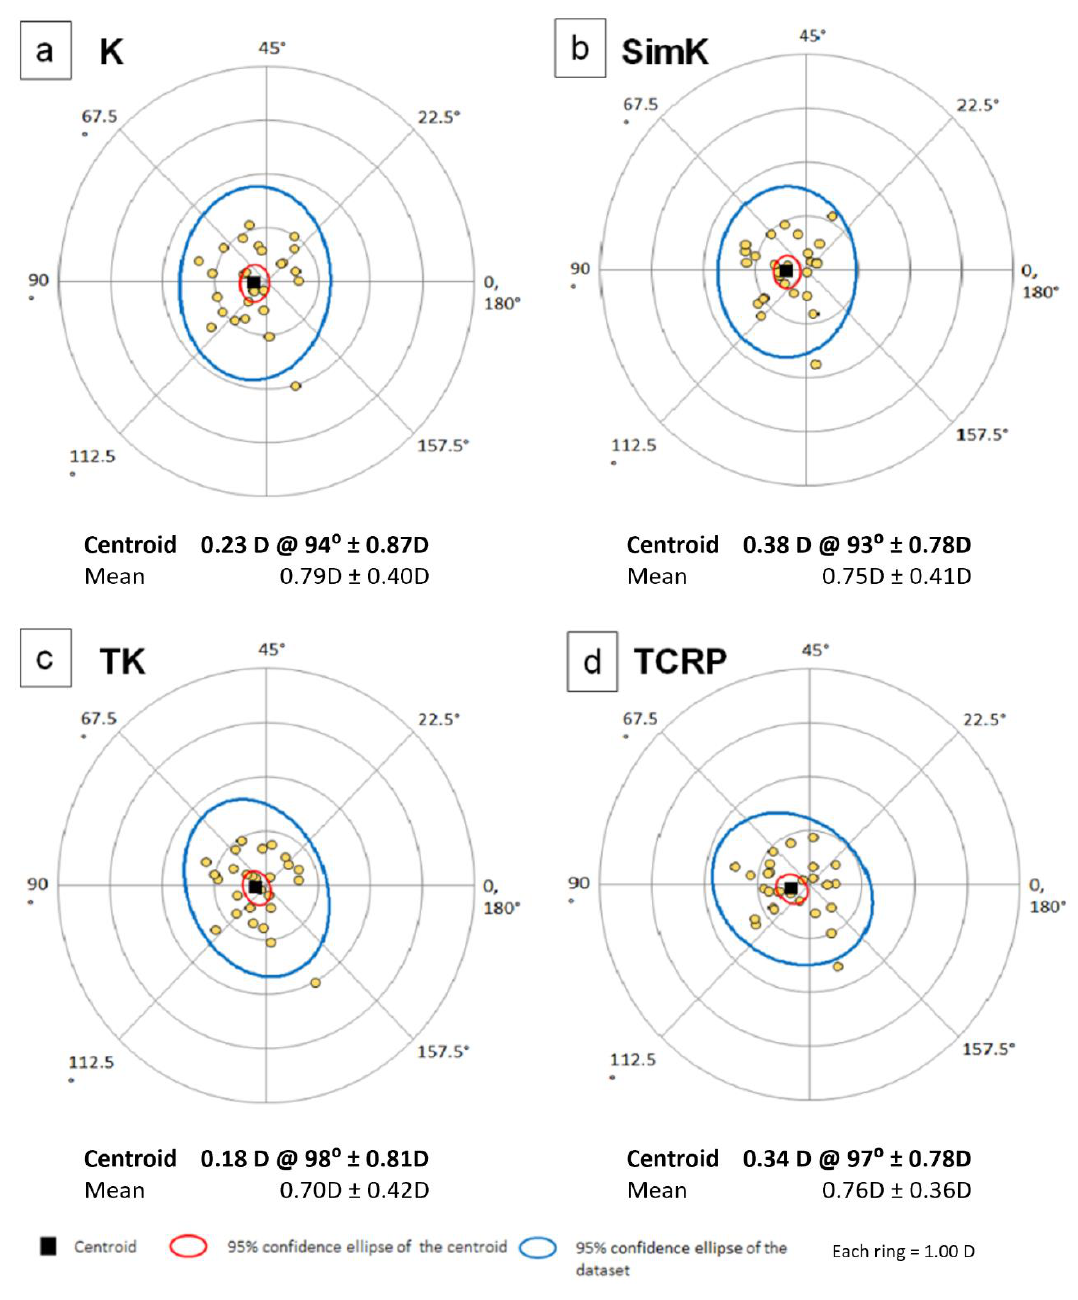
Figure 5. Double-angle plots showing the astigmatism measured with ( a ) K, ( b ) simK, ( c ) TK, ( d